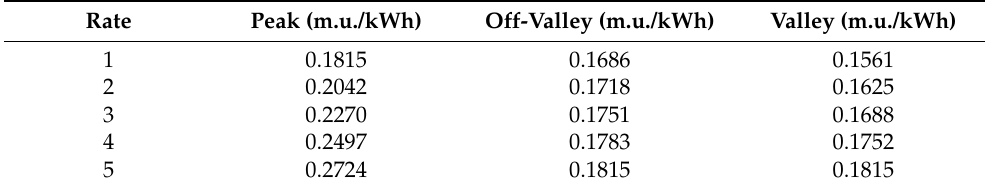
Table 3. Consumer contextual trustworthy rate tariffs applied.